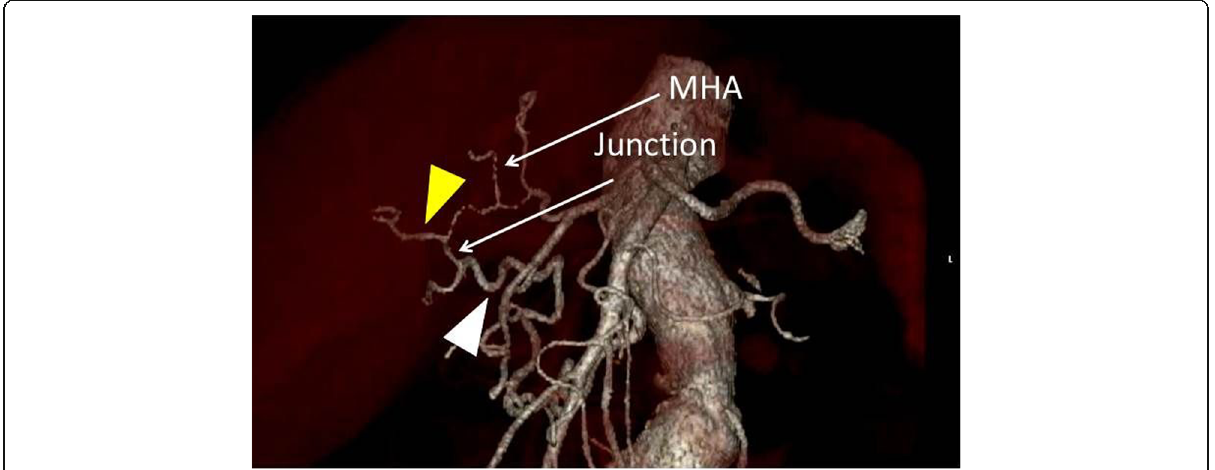
Fig. 2 A 3D reconstruction of CT showed there were middle hepatic artery (labeled as “ MHA ” ) and a junction (labeled as “ junction ” ) between RHA-PB ( white arrow head ) and RHA-AB ( yellow arrow head ) at the hilar